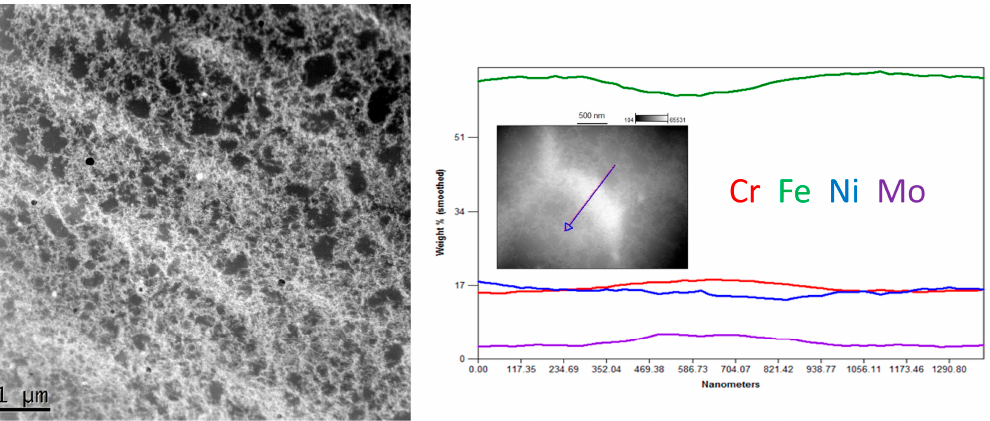
Figure 10. Exemplary STEM image of Sample C (0.2 mm) with linear chemical composition